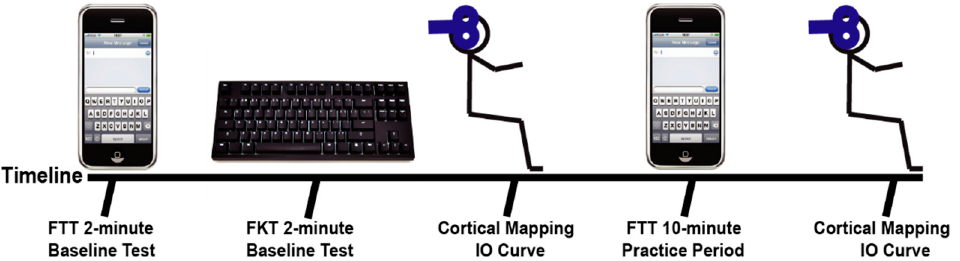
Figure 1. Experimental timeline for the functional texting task and functional keyboard task base- line test (FTT and FKT), baseline cortical mapping and IO curves, practice period, and the final cortical mapping and IO